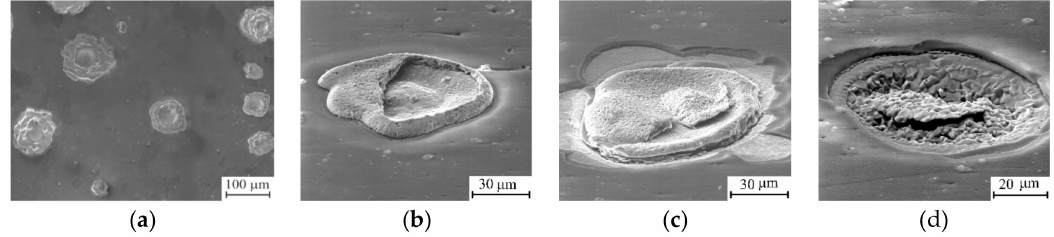
Figure 3. SEM micrographs of Al 0.88 Si 0.12 N coating after 20 ( a , b ) and 25 ( c , d ) thermal cycles.